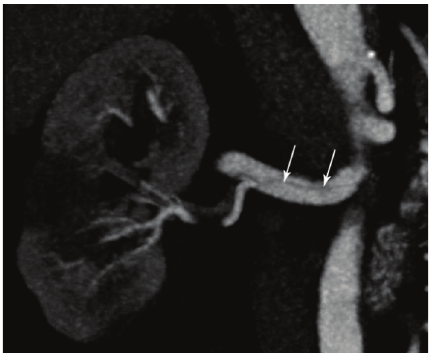
Figure 2: Findings: maximum intensity projection, in coronal plane of CT renal angiography in arterial phase demonstrating linear filling defect in main renal artery, suggests intimal flap (long